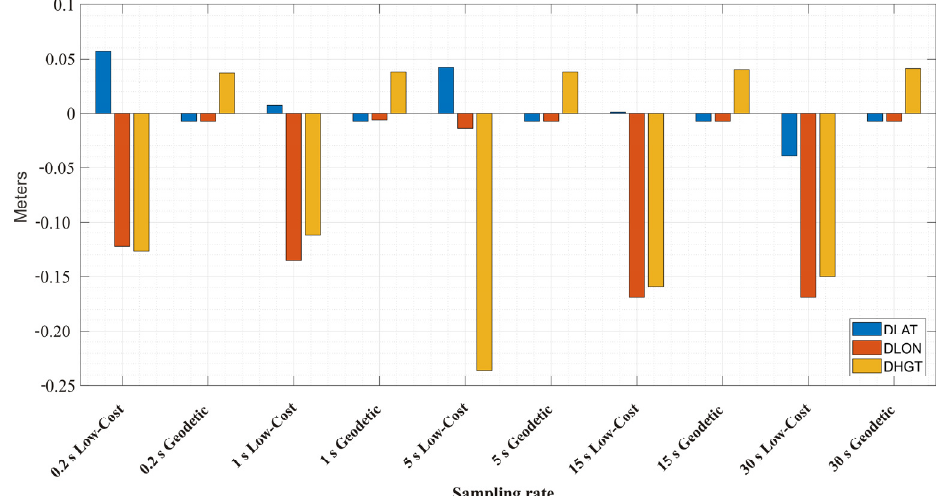
Figure 6. Difference between estimated and precise coordinates of the low-cost and geodetic receiver by processing with PPP-static mode.